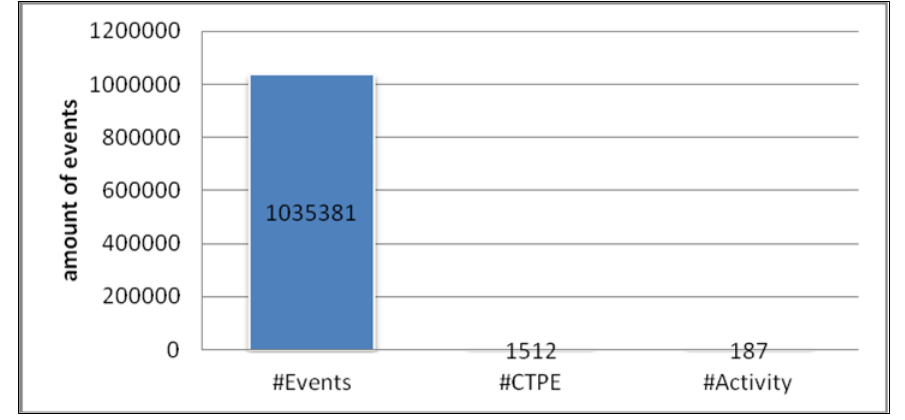
Figure 5. Ratio between incoming events generated CTPEs and fired activities of one patient of the University of Queensland data